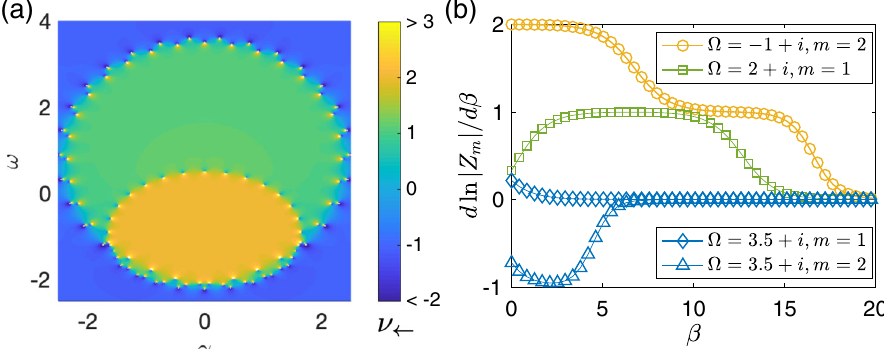
Fig. 3 The topological phase diagram and simulation of impedance measurement in a circuit realization. a The topological phase diagram, in excellent agreement with that shown in Fig. 1, is mapped out from examining physical response functions ν ¼ Max ½ ν ; 1 ; ν ; 2 (cid:5) for the model depicted in the main text, with parameters set at t 1 = 1, t − 1 = 0.5, t 2 = 2, t − 2 = 0, and N = 100. The reference energy for de fi ning ν ← is given by E r = ω + i γ . At the phase boundary, E r is an eigenvalue of the system under the periodic boundary condition, leading to the divergence of the Green ’ s function matrix. b Quantization of d ln j Z m j d β , which is directly obtainable from simulated circuit measurement data of the impedance between the fi rst m and last m nodes of the circuit lattice, here computed with 50 nodes. Z m (Eq. (10)) is the m × m matrix of impedances between the measured nodes, and β is the parameter controlling the strengths of the couplings connecting the two ends. The complex admittance parameter Ω indicated on panel b is connected with parameters ω and γ plotted in panel a with ω ¼ Re ð Ω Þ and γ ¼ Im ð Ω Þ . The fi rst plateau encountered when β is increased from zero gives the nonzero topological winding ν (green, yellow for ν = 1, 2). When ν = 0, the logarithmic gradients of both Z 1,2 are close to or smaller than 0 (blue), corresponding to the absence of signal ampli fi cation toward either direction.